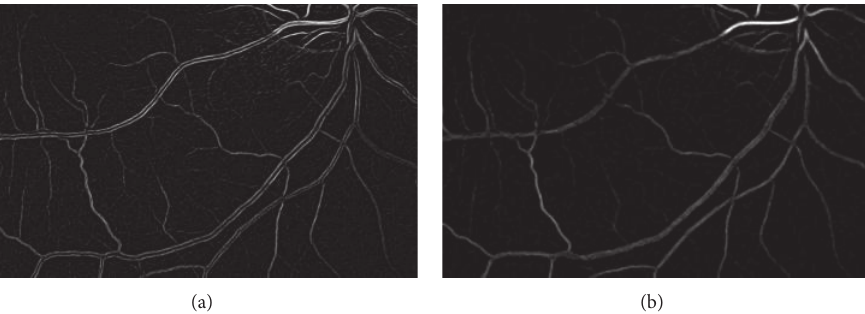
Figure 5: The resized vesselness images of two different resolution levels. In the highest resolution level (a) the enhanced image shows more details, while the result of a lower resolution level (b) shows a more accurate segmentation of thick vessels.